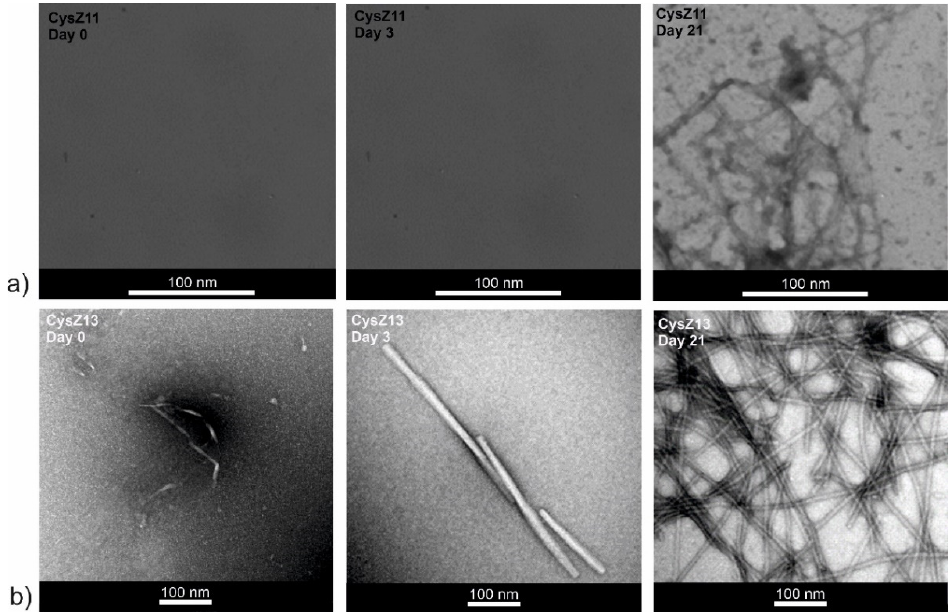
Figure 6. Transmission electron micrographs (TEM) for peptides ( a ) CysZ11 and ( b ) CysZ13, taken before, on the 3rd day, and after 21 days of incubation in PBS buffer pH 7.4.